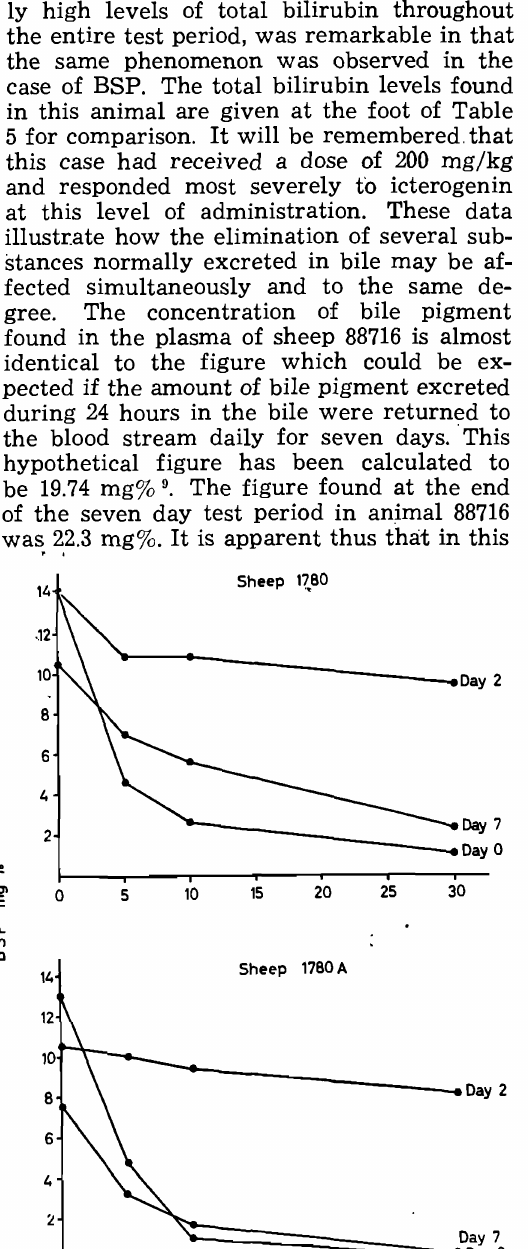
Fig.: BSP clearance in cases dosed with icterogenin (Day O=the day before dosing was commenced; Days 2 and 7 are days after dosing; BSP mg % - plasma levels of BSP; Time in minutes-minutes after inj ec tion)